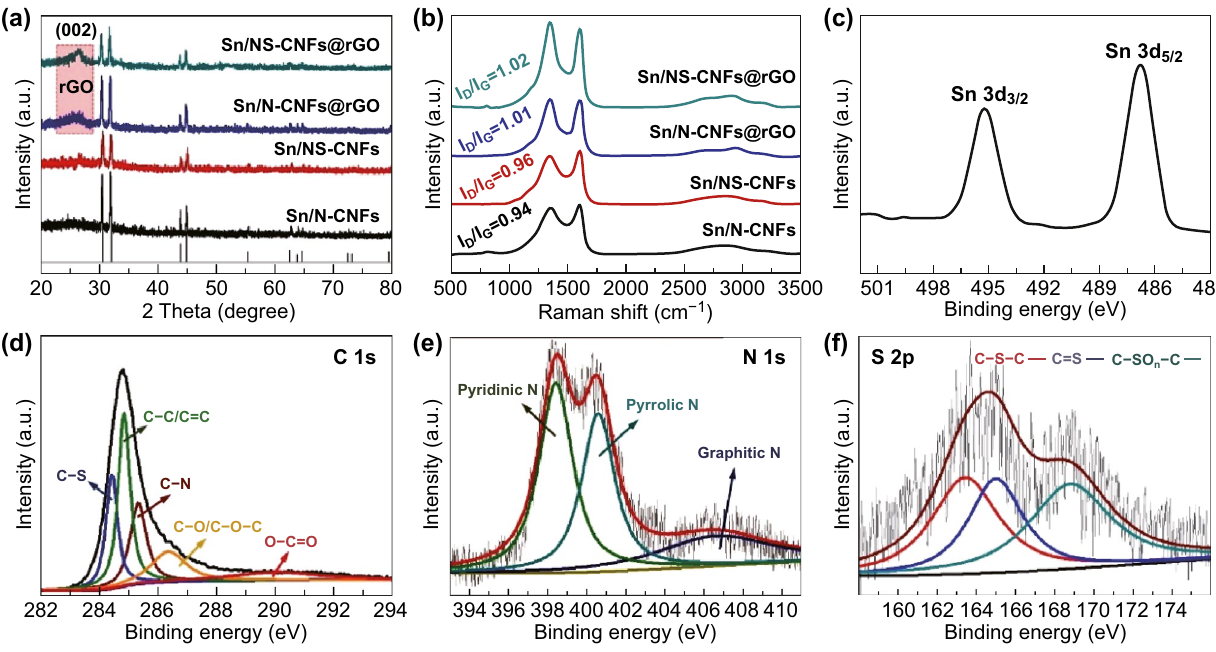
Fig. 3 a XRD patterns and b Raman spectra of Sn/N‑CNFs, Sn/NS‑CNFs, Sn/N‑CNFs@rGO, and Sn/NS‑CNFs@rGO. High‑resolution XPS spectra of c Sn 3 d , d C 1 s , e N 1 s , and f S 2